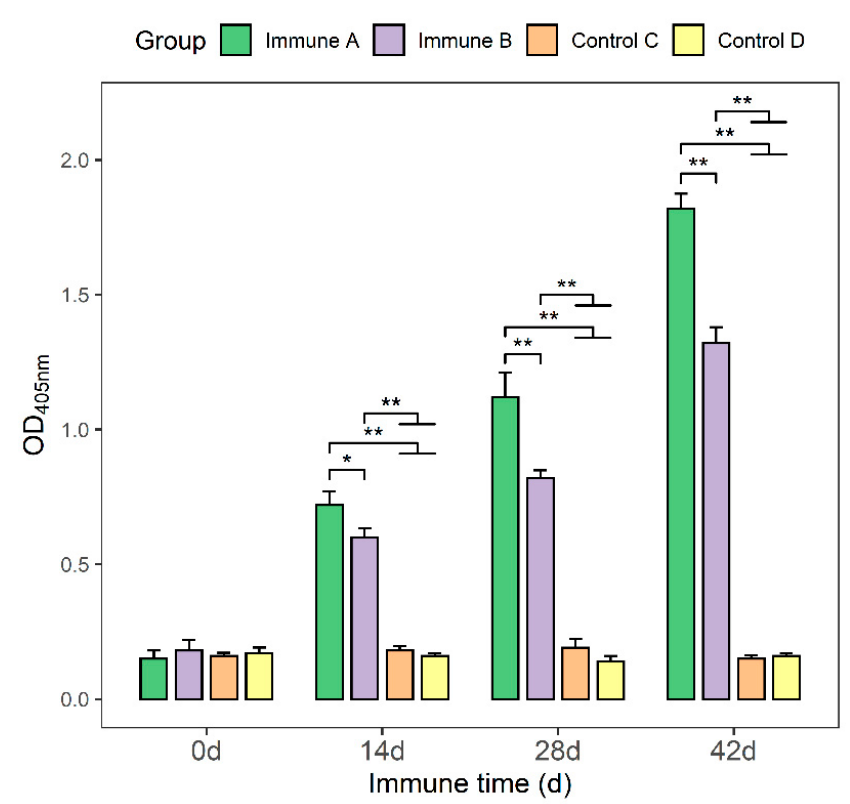
Figure 3. Antibody titers in sera of immunized mice. The OD 405 nm was calculated for each group of mice ( n = 5). An error bar shows the standard error of the mean. Mice in group A received the purified rMseno protein. Mice in group B received IPTG-induced E. coli -Mseno. Control group C received an equal volume of PBS. Control group D received uninduced recombinant E. coli -Mseno. Each group received three immunizations on day 0, day 14, and day 28. Antibody titers were determined until day 42. * p < 0.05 presents a significant difference, and ** p < 0.01 shows a highly significant